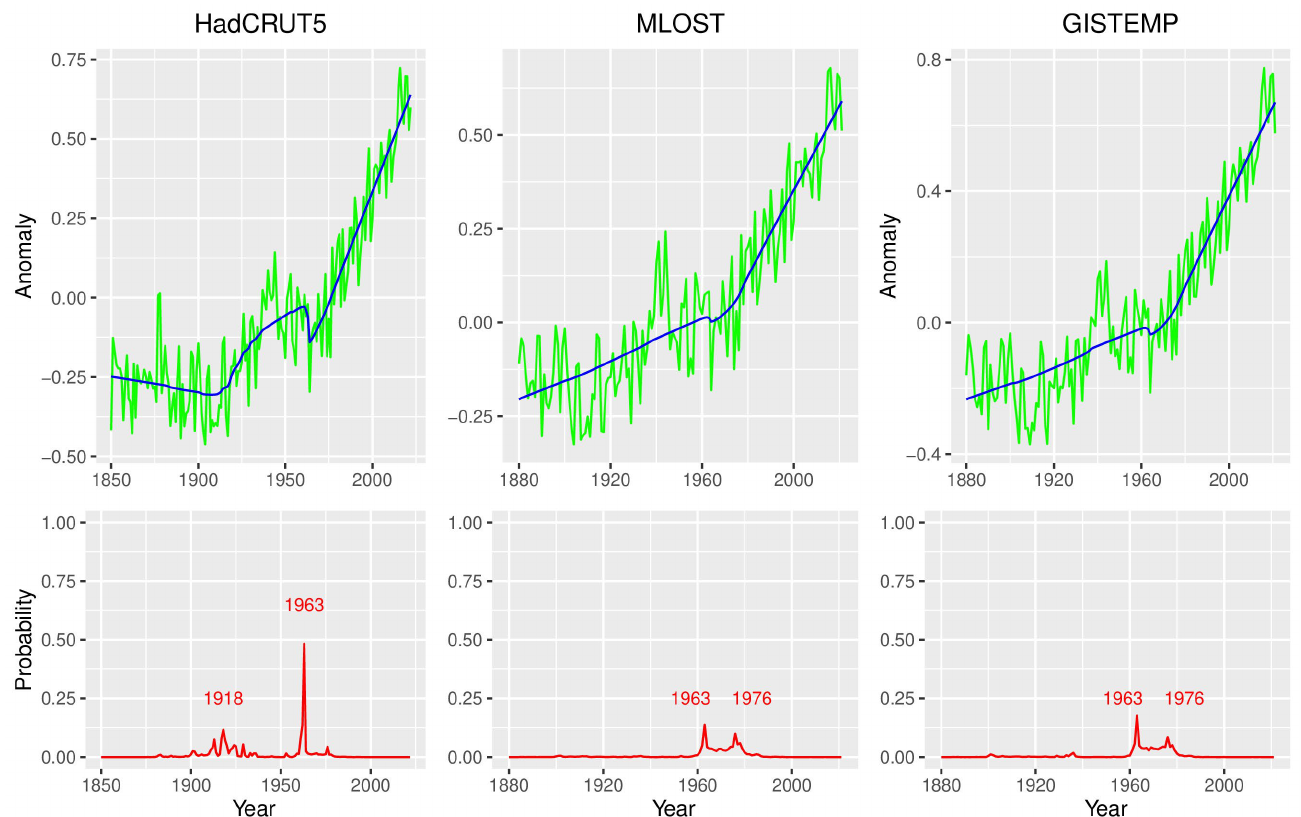
Figure 6. Change Points in the Temperature Anomaly Data. The top row displays the HadCRUT5, MLOST, and GISTEMP datasets, along with the model fitted by using BMA together with the Bayesian change point model. The bottom row displays the BMA posterior distribution for the locations of change points in each dataset. HadCRUT5 has two change points detected by the model, while MLOST and GISTEMP have a bimodal distribution for a single change point.